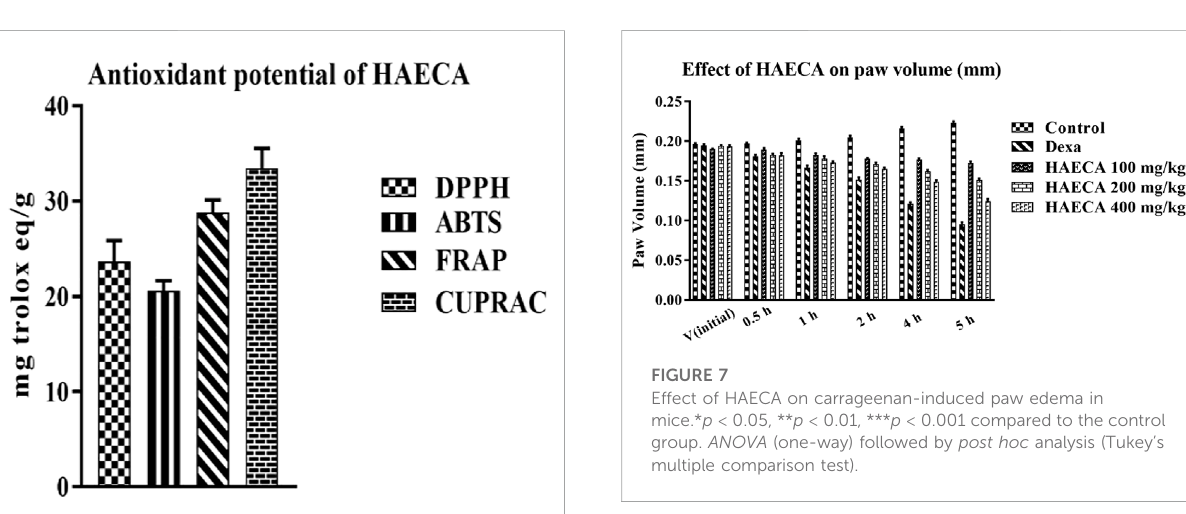
FIGURE 6 Antioxidant potential of HAECA.